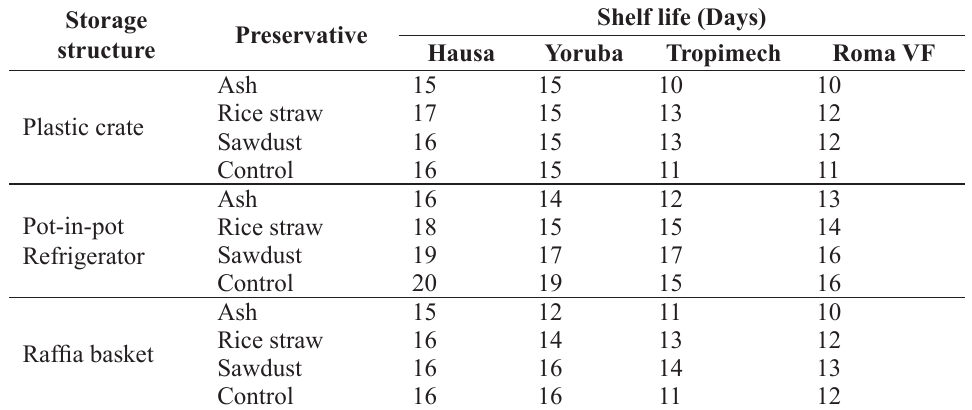
Table 1: Shelf life (day) of four varieties of tomato fruits as influenced by storage structures and botanical preservatives. Storage